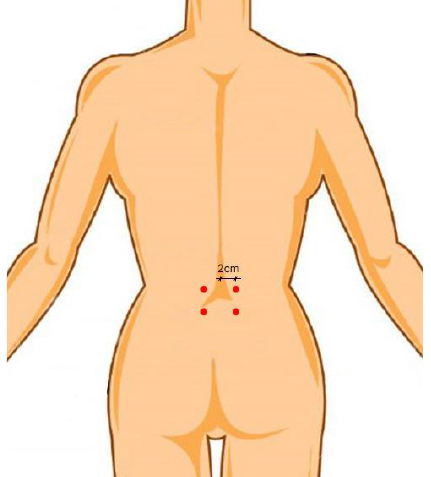
Table 2. Procedures of the selected exercises.